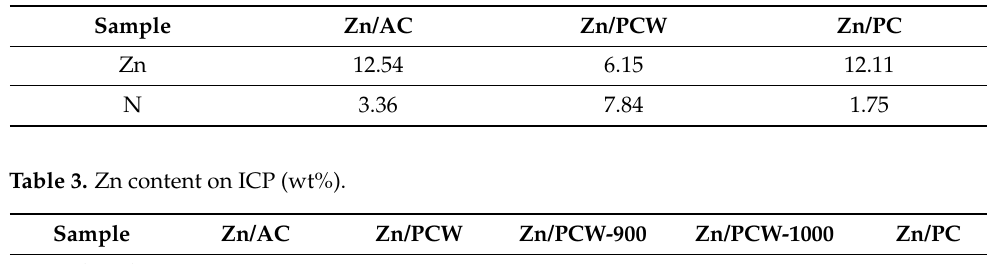
Table 2. Zn content on XPS (wt%).